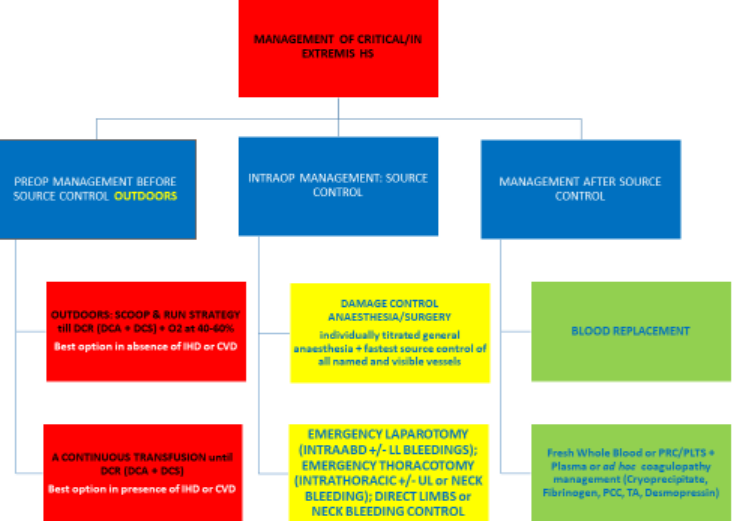
Figure 4. Management of stage IV HS. DCR = damage control resuscitation; DCA = damage control anesthesia; DCS = damage control; SURGERY LL = lower limbs; UL = upper limbs; PRC = packed red cells, PLTS = platelets; PCC = prothrombin complex concentrates; TA = tranexamic acid, IHD = ischemic heart disease; CVD = cerebrovascular disease.